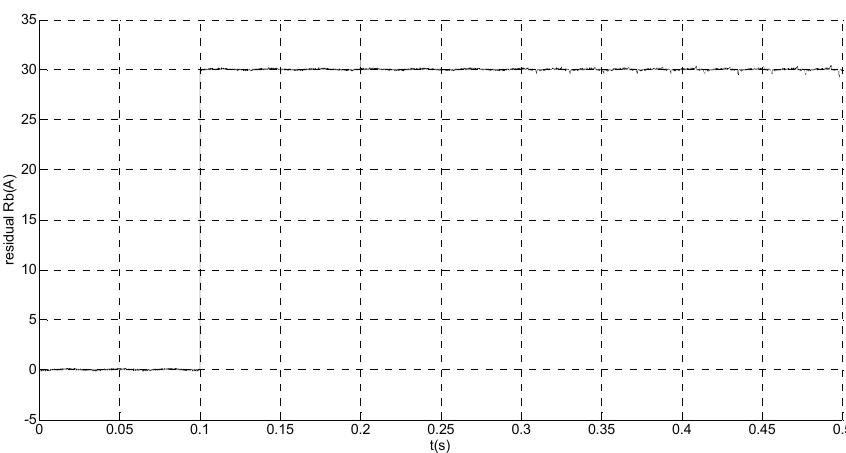
Figure 21. Simulation result of current residual in phase ‘a’.